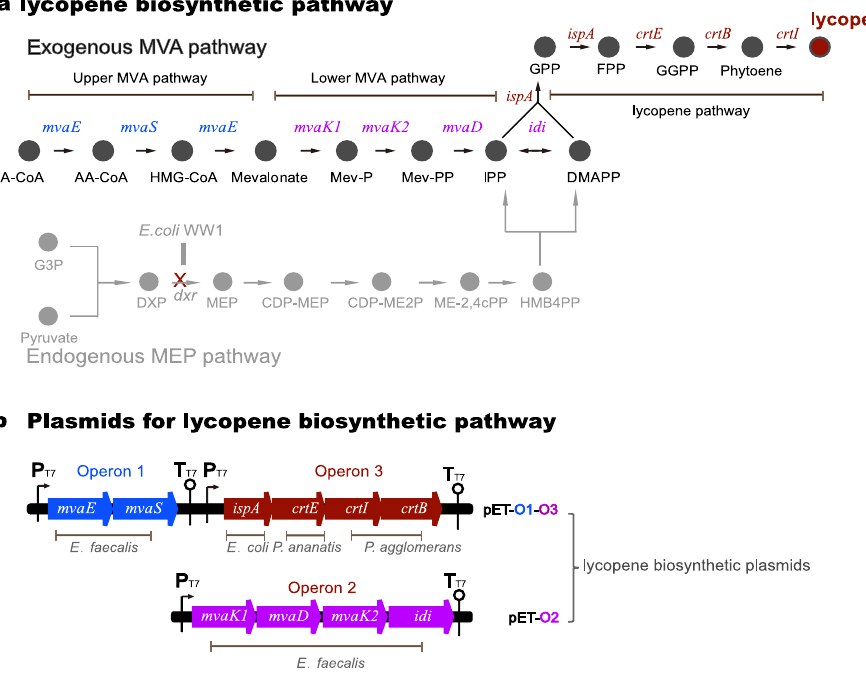
Figure 2. The heterogenous lycopene biosynthetic pathway constructed in this study. ( a ) Depiction of the synthetic pathway. The endogenous MEP pathway of E. coli is indicated in gray. The lycopene biosynthetic pathway, including the MVA and lycopene pathways is depicted in black. ( b ) Plasmids and indicated operons for lycopene production (information about genes is provided in the Supplementary Data). mvaE , hydroxymethylglutaryl-CoA reductase; mvaS , hydroxymethylglutaryl-CoA synthase; mvaK1 , mevalonate kinase; mvaK2 , phosphomevalonate kinase; mvaD , diphosphomevalonate decarboxylase; idi , isopentenyl- diphosphate delta-isomerase; ispA , farnesyl diphosphate synthase; crtE , geranylgeranyl pyrophosphate synthase; crtB , phytoene synthase; crtI , phytoene dehydrogenase; A-CoA, acetyl-CoA; AA-CoA, acetoacetyl-CoA; Mev-P, mevalonate 5-phosphate; Mev-PP, mevalonate pyrophosphate. HMG-CoA, hydroxymethylglutaryl- CoA; IPP, isopentenyl diphosphate; DMAPP, dimethylallyl diphosphate; GPP, dimethyl pyrophosphate; FPP, farnesyl diphosphate; GGPP, geranylgeranyl pyrophosphate; G3P, glyceraldehyde 3-phosphate; DXP, 1-deoxy- D-xylulose 5-phosphate; dxr, DXP reductoisomerase; MEP, 2-C-methyl-D-erythritol 4-phosphate; CDP-ME, 4-diphosphocytidyl-2-C-methyl-D-erythritol; CDP-ME2P, 4-diphosphocytidyl-2-C-methyl-D-erythritol 2-phosphate; ME-2,4cPP, 2-C-methyl-D-erythritol 2,4-cyclopyrophosphate; HMB4PP, 1-hydroxy-2-methyl-2- (E)-butenyl 4-pyrophosphate.